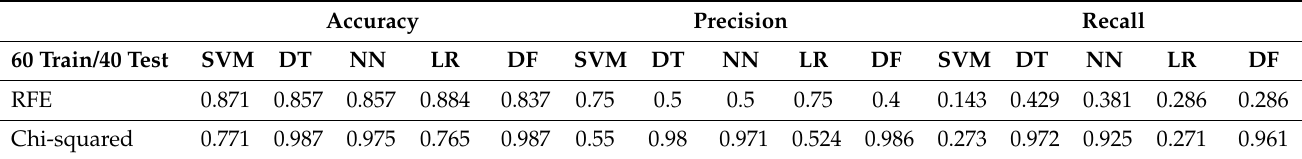
Table 3. Comparative analysis of active risk